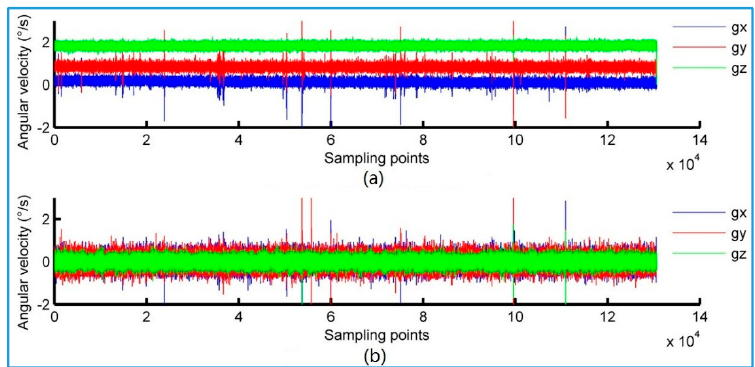
Figure 10. Contrast diagram before and after complementary filtering. ( a ) Gyro original angular velocity; ( b ) Filtered angular velocity.